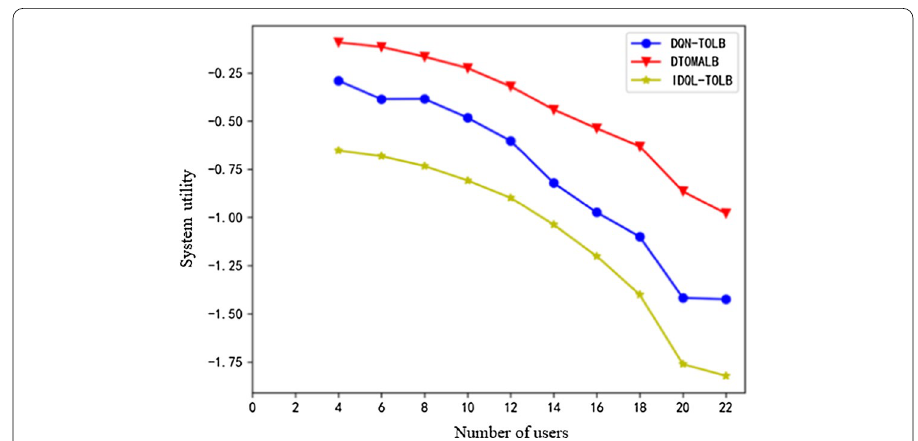
Fig. 7 The relationship between system utility and number of